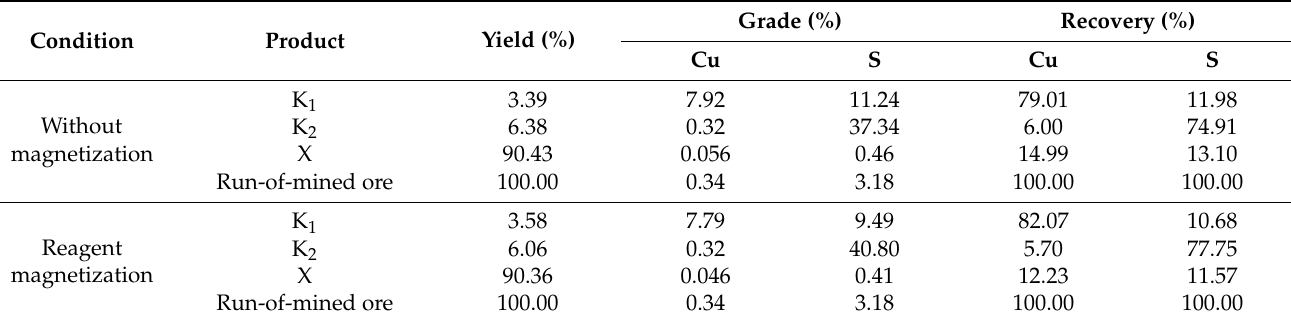
Table 4. The results of closed-circuit